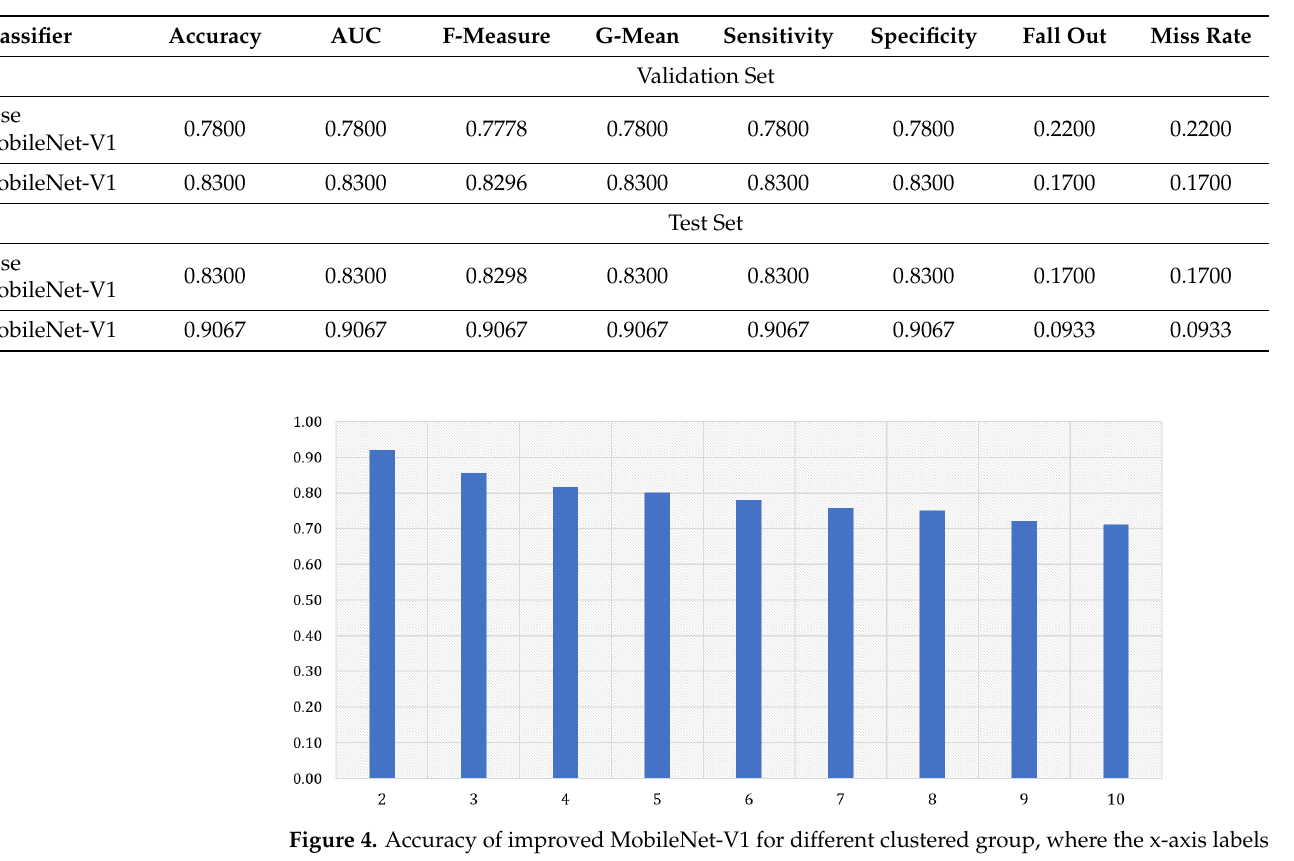
Table 4. Comparison the results between Base and Improved MobileNet-V1 for Validation and Test Set.